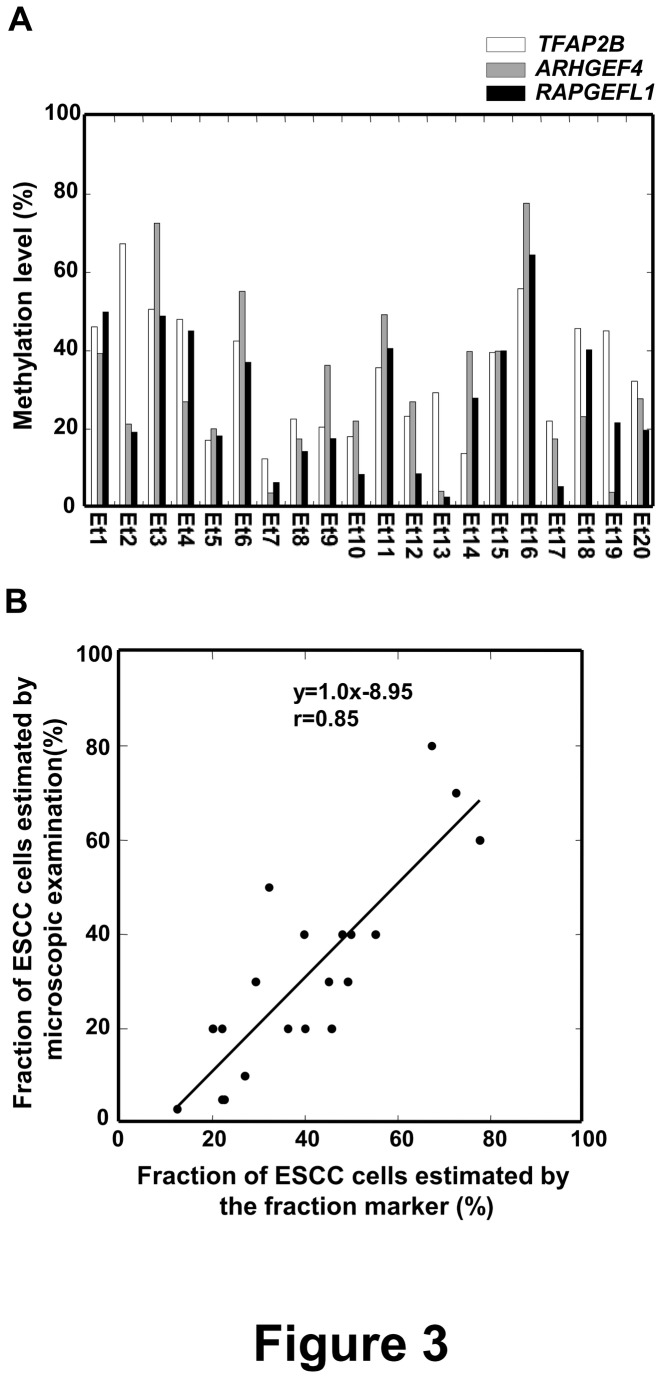
Analysis of the accuracy of the fraction marker.(A) Methylation levels of the three regions were analyzed in 20 ESCCs by MS-HRMA. The fraction of cancer cells in each sample was defined as the highest methylation level of the three regions. (B) Correlation between the fraction of cancer cells estimated by the fraction marker and that assessed by microscopic examination. The correlation between the two methods, calculated using Pearson's product-moment correlation coefficient, was sufficiently high (r=0.85).